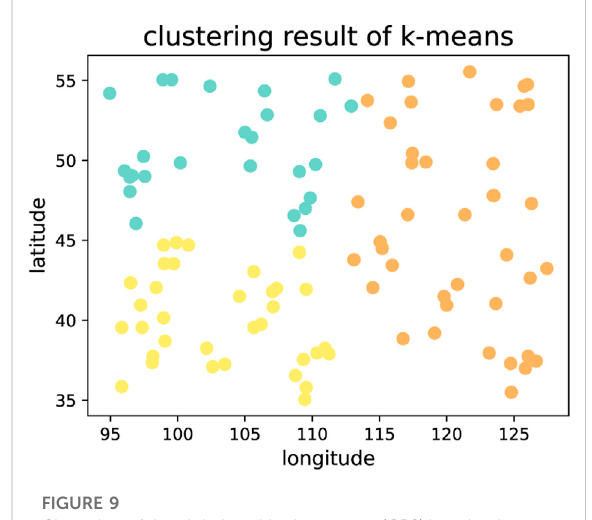
FIGURE 9 Clustering of the global positioning system (GPS) location by k-means.